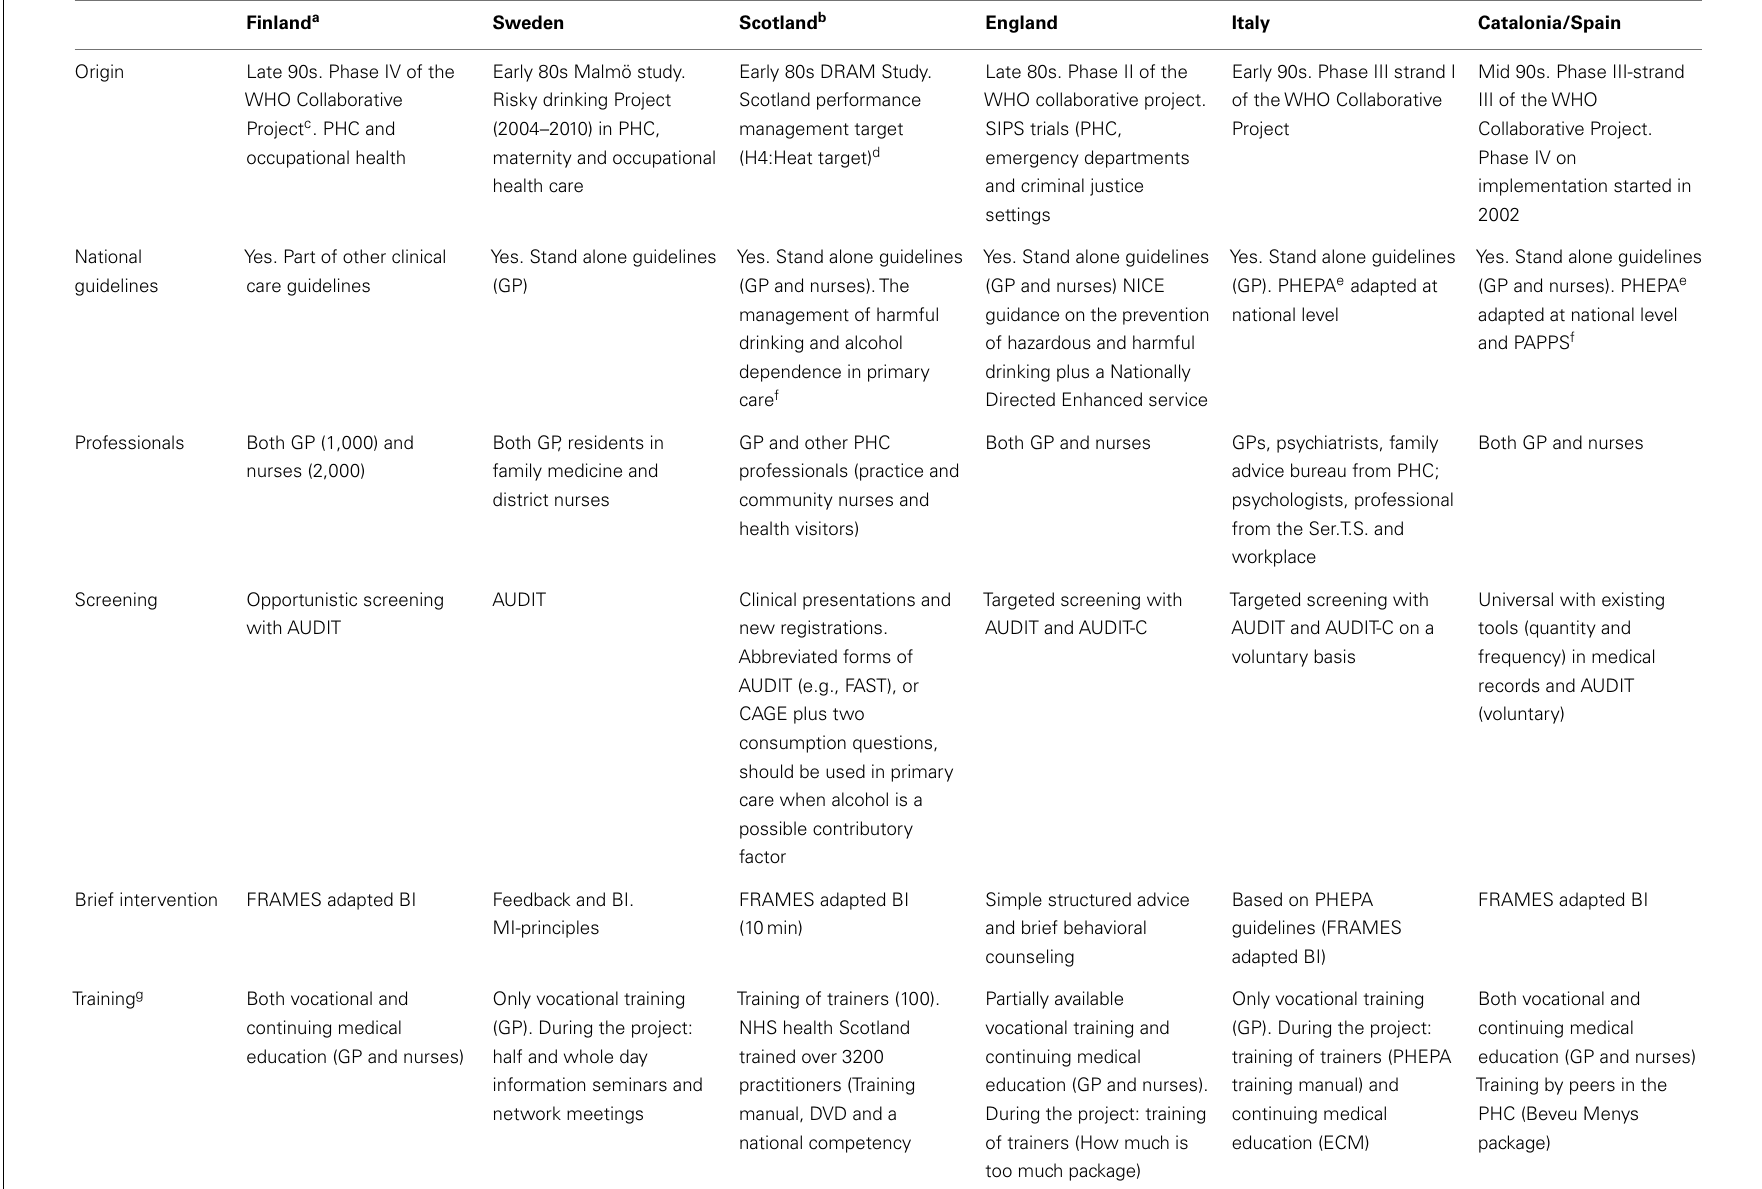
Table 2 | SBI programs characteristics